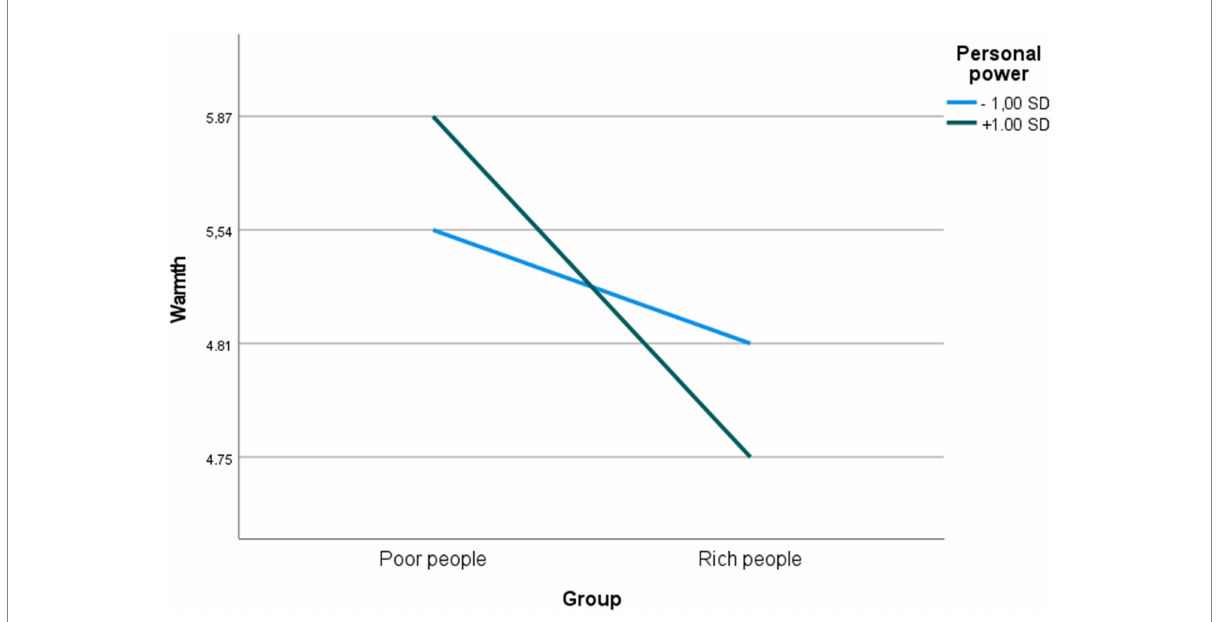
FIGURE 1 Predicted perceptions of warmth at high and low levels of personal power.